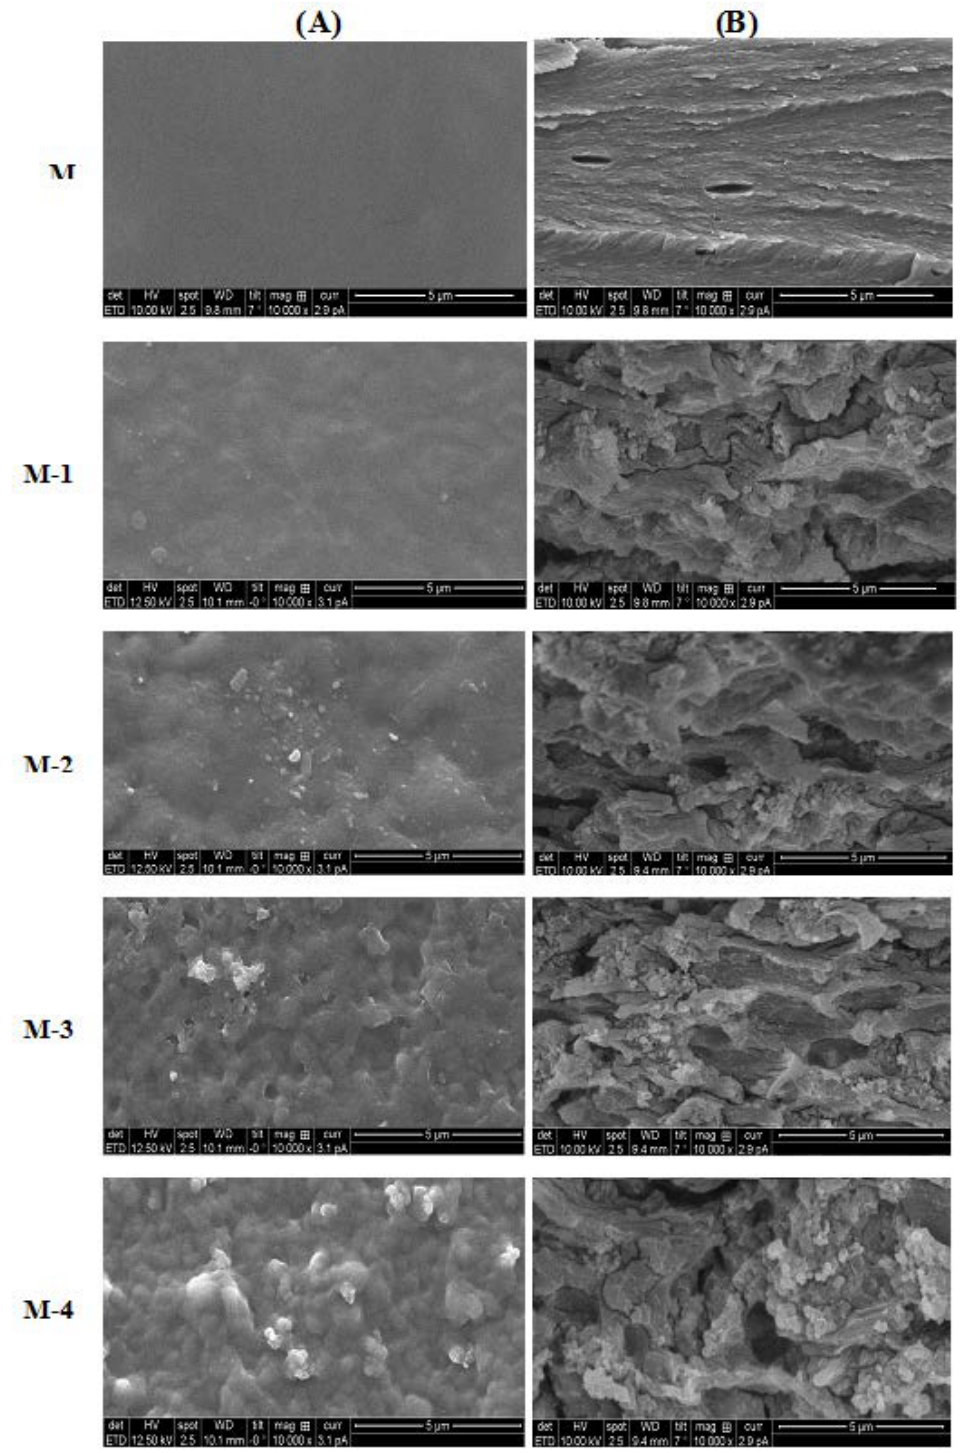
Figure 4. Scanning electron microscopy micrographs of crosslinked sodium alginate and related nanocomposite membranes. ( A ) surface views and ( B ) cross-sectional views.